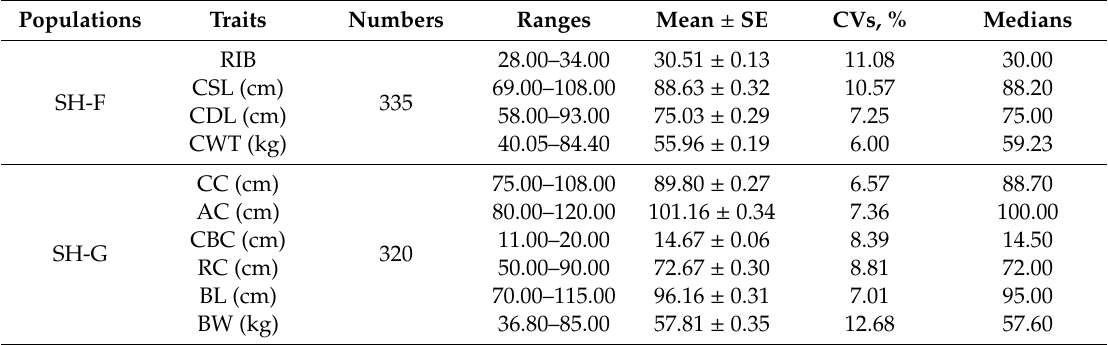
Table 1. Descriptive statistics analyses of the number of ribs and carcass traits in Suhuai fattening pigs and body size / body weight traits in Suhuai gilts.